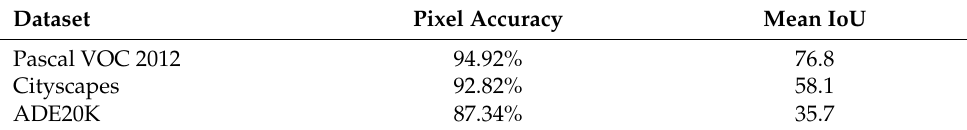
Table 16. Performances of the best proposed model.